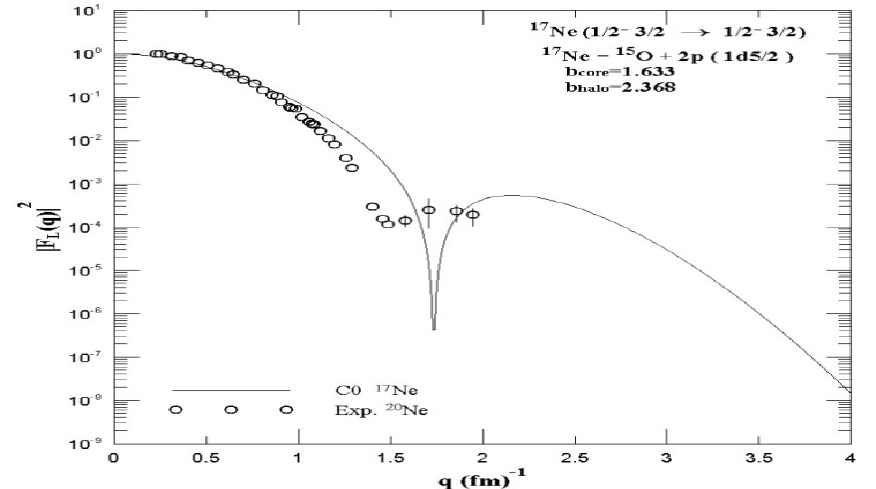
Fig. 4: The calculated elastic longitudinal C0 form factors of 17 Ne with two protons in 1d orbit. the experimental data are taken from Refs [31,32]. 3/2